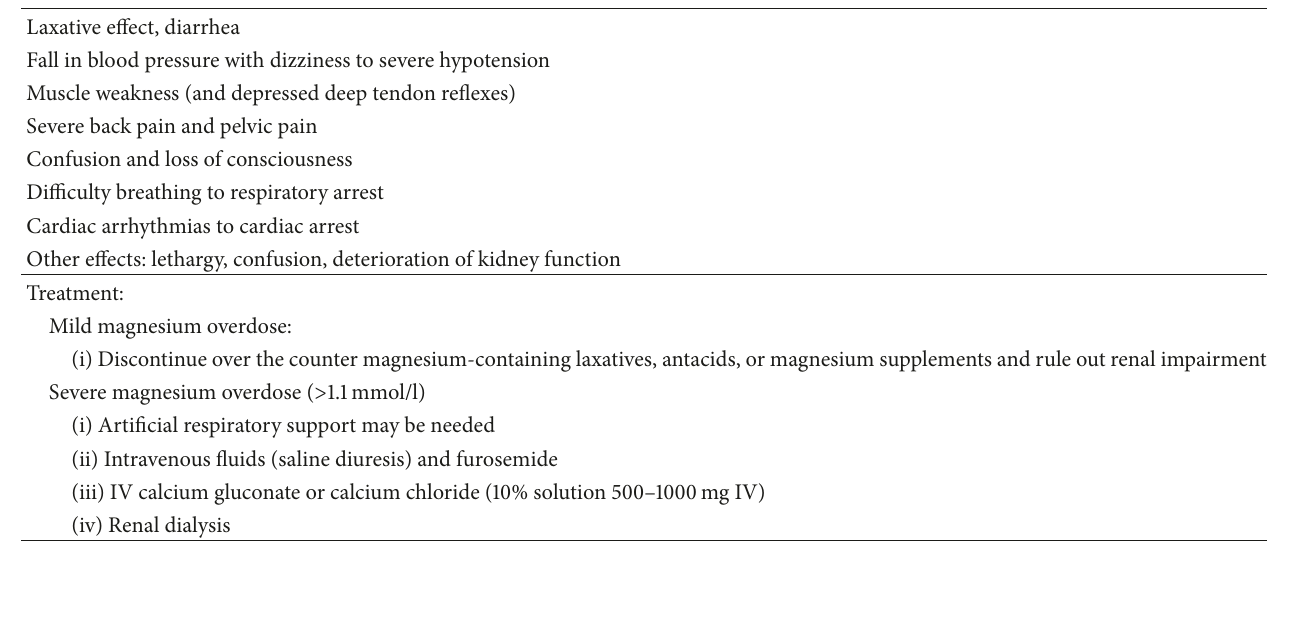
Table 9: Signs and symptoms of magnesium toxicity and clinical